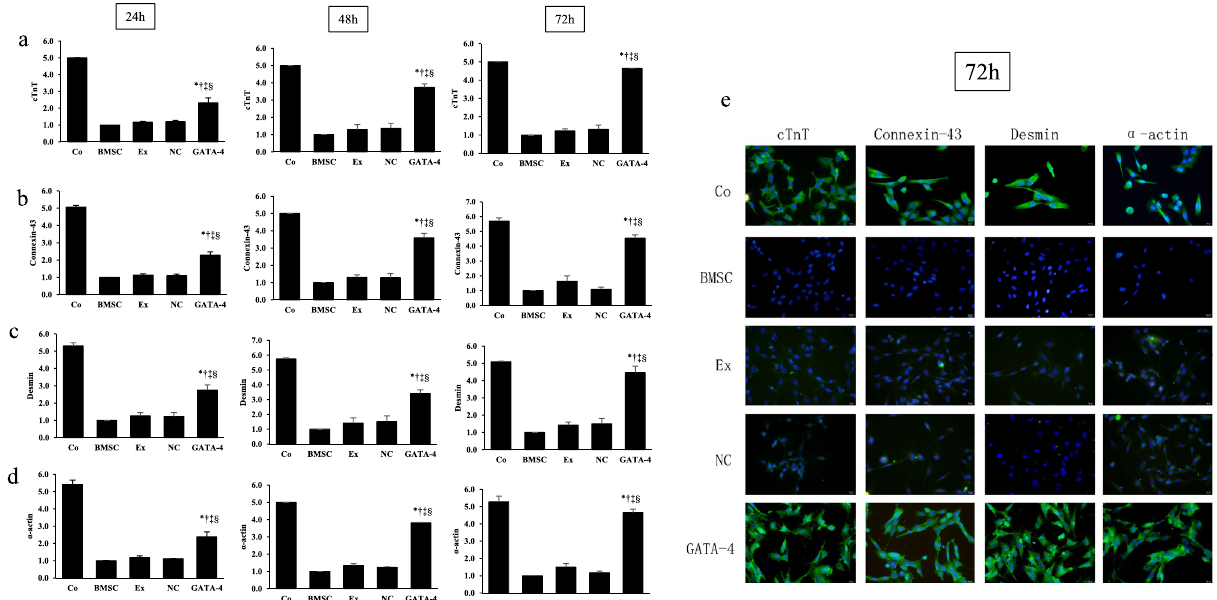
Figure 2. The effect of GATA-4-BMSC exosomes cardiomyocyte marker expression. The mRNA expression of ( a ) cTnT, ( b ) connexin-43, ( c ) desmin, and ( d ) α-actin was analyzed by quantitative PCR in BMSCs following co-culture with GATA-4-BMSC exosomes, NC-BMSC exosomes, BMSC exosomes compared with BMSCs only and cardiomyocyte single cultures. *,†,‡,§ p < 0.05, significantly different from the *BMSC group, † BMSC exosome group. ‡ NC-BMSC exosome group, and § cardiomyocyte group. Co, control; BMSC, BMSC only; Ex, exosome BMSC; NC, NC-exosomes; GATA-4, GATA-4-BMSC